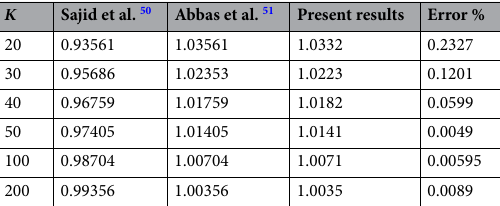
K Sajid et al. 50 Abbas et al. 51 Present results Error